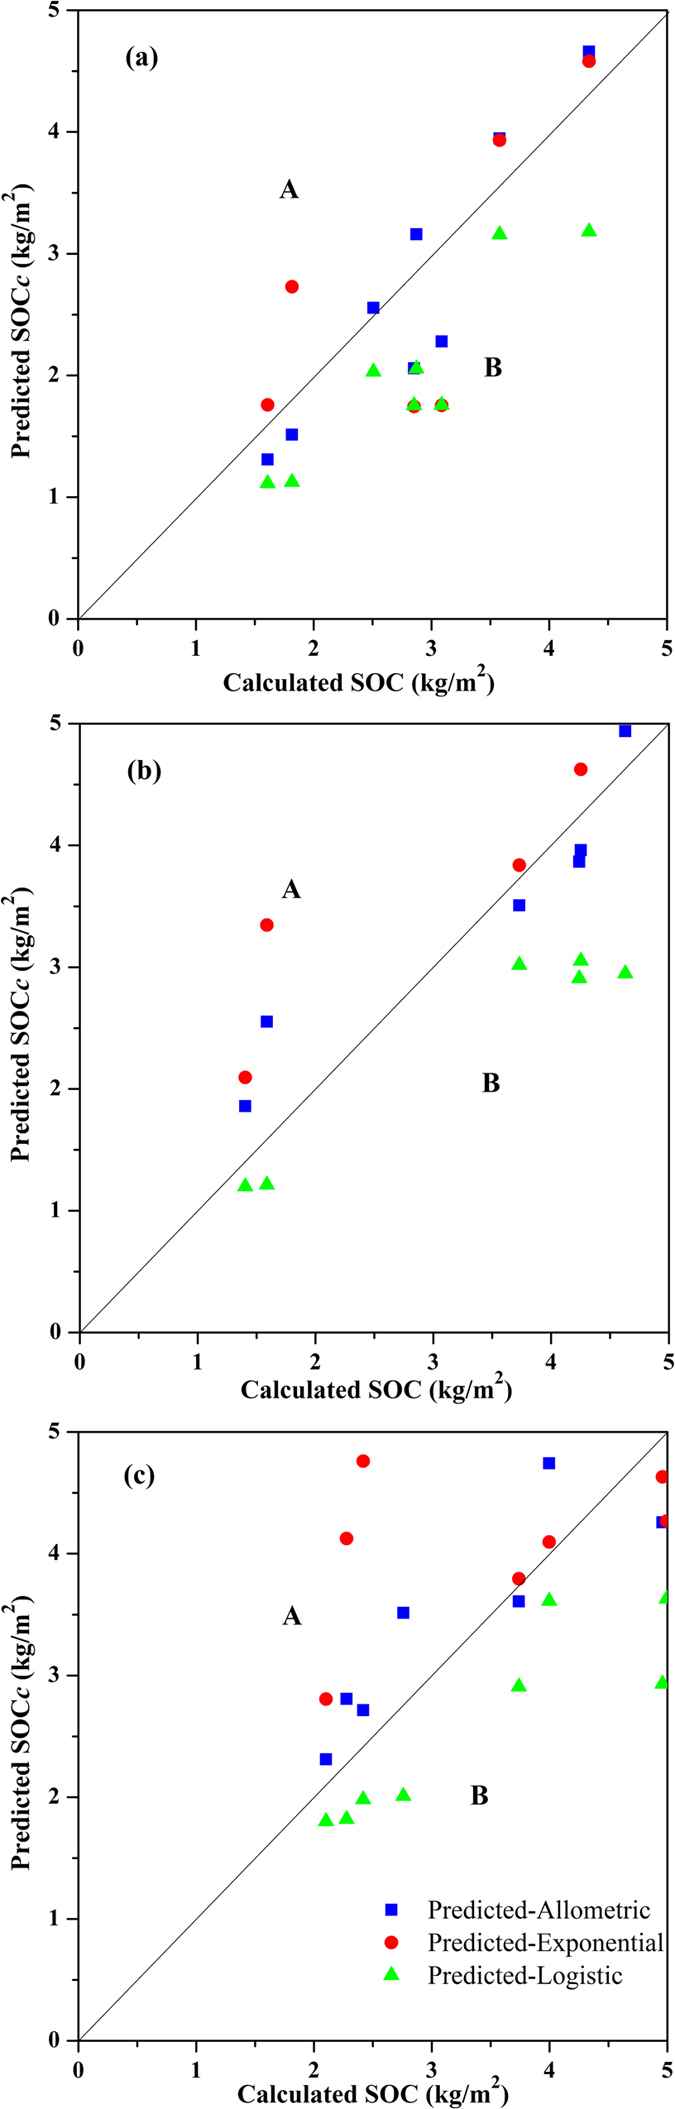
Prediction results obtained using three functions and the relationship between predicted and calculated cumulative SOC stocks (SOCc) in PSM (a), SSM (b) and TSSM (c). Some unusual predicted values are not shown in this figure. Area A denotes overestimations, and area B denotes underestimations.